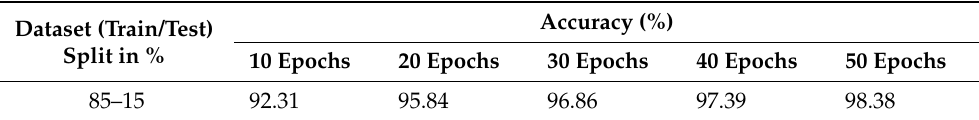
Table 4. Data Split for Testing/Training & Accuracy